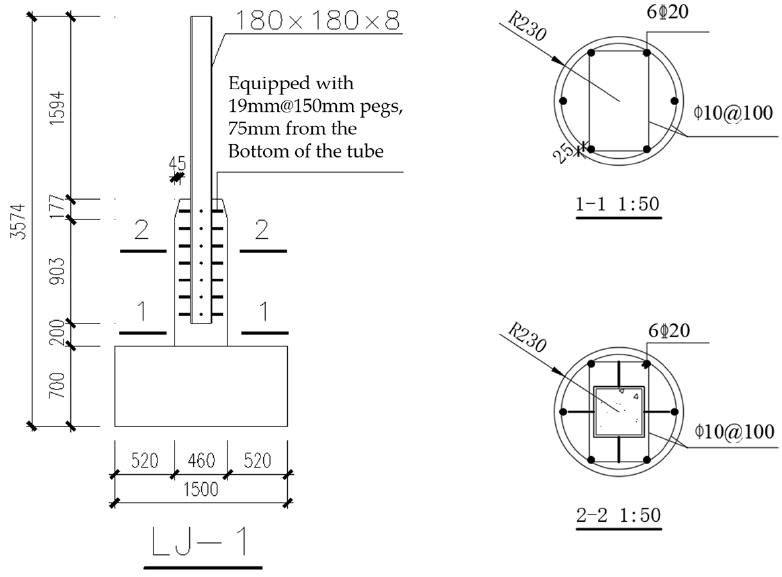
Figure 2. Dimensions and reinforcement of LJ-1 specimen.